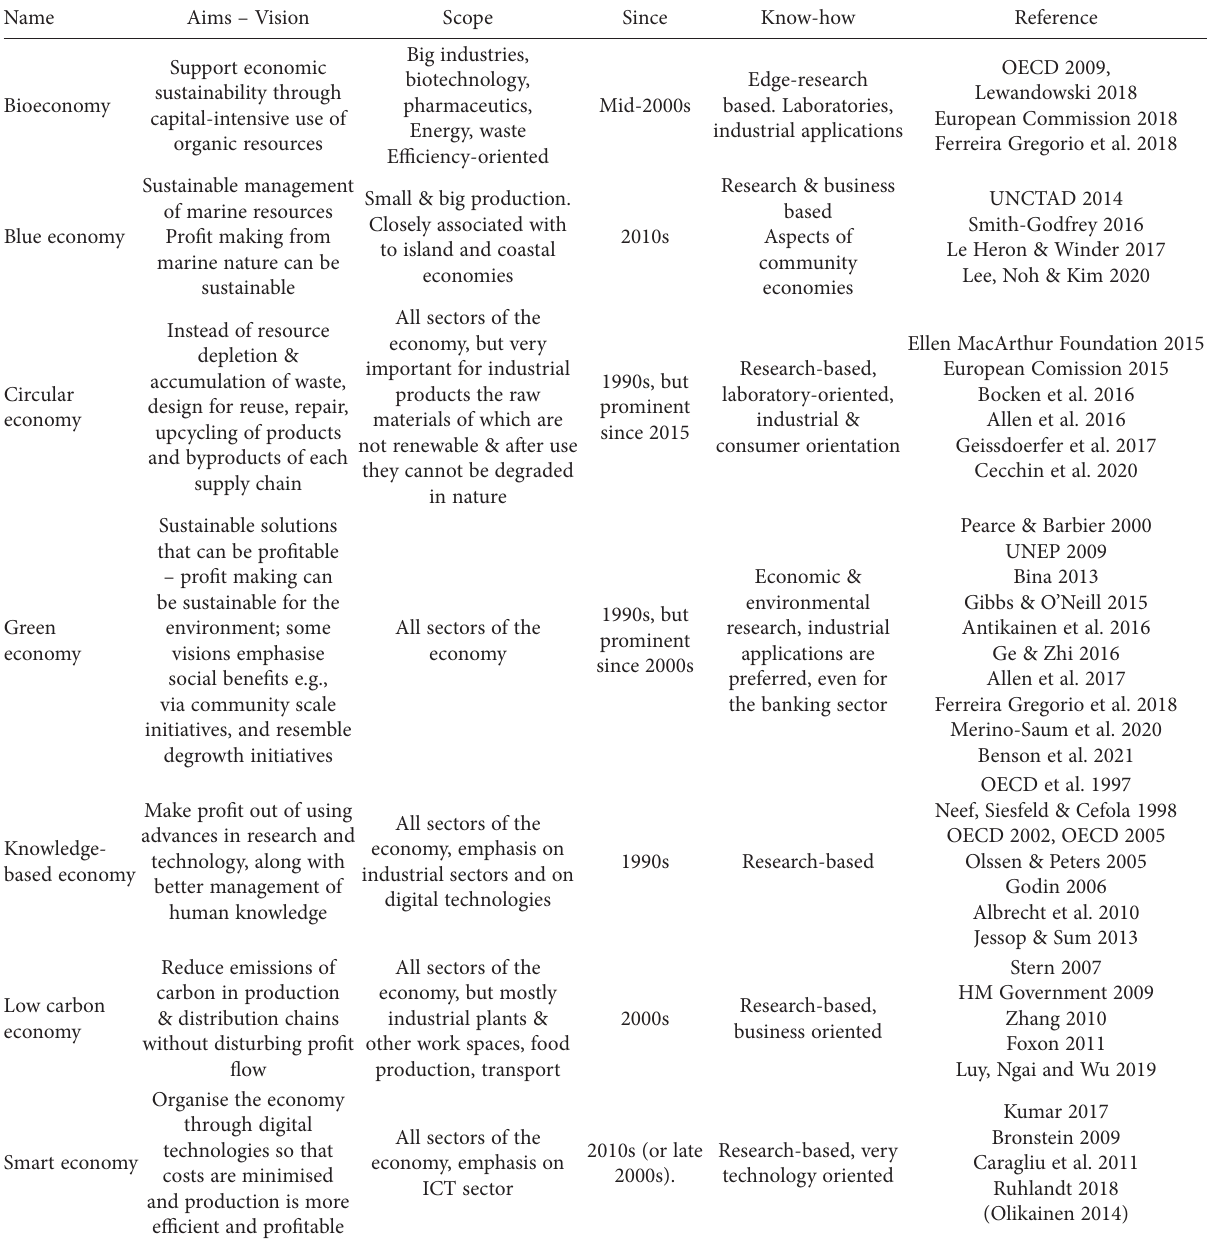
Table 4. A non-exhaustive list of what we term the Sustainability or S economies. These various expressions have been adopted to promote a particular economic activity as approaches to value generation. The decade of origin and key policy and academic references are